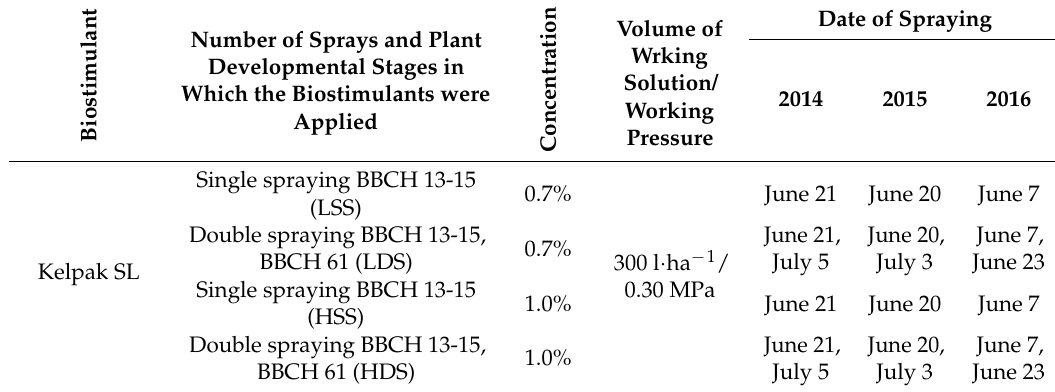
Table 1. Plant developmental stages and dates of biostimulants application.